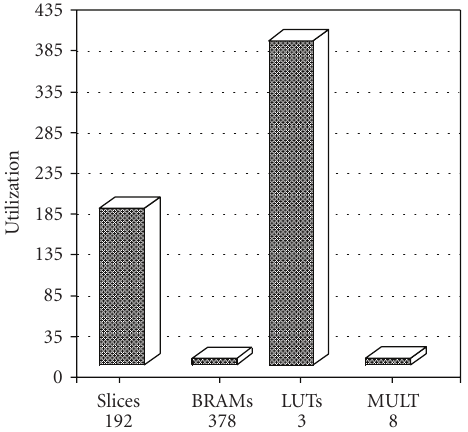
Figure 5: Utilization of the components in the FPGA Virtex